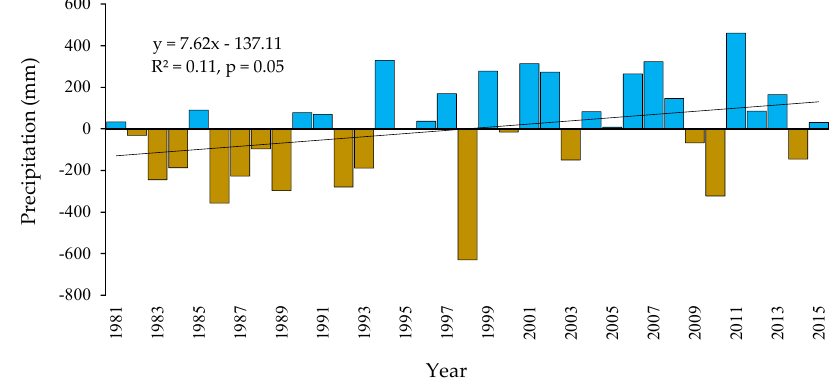
Figure 3. Observed annual minimum temperature anomalies in Myanmar during 1981–2015.